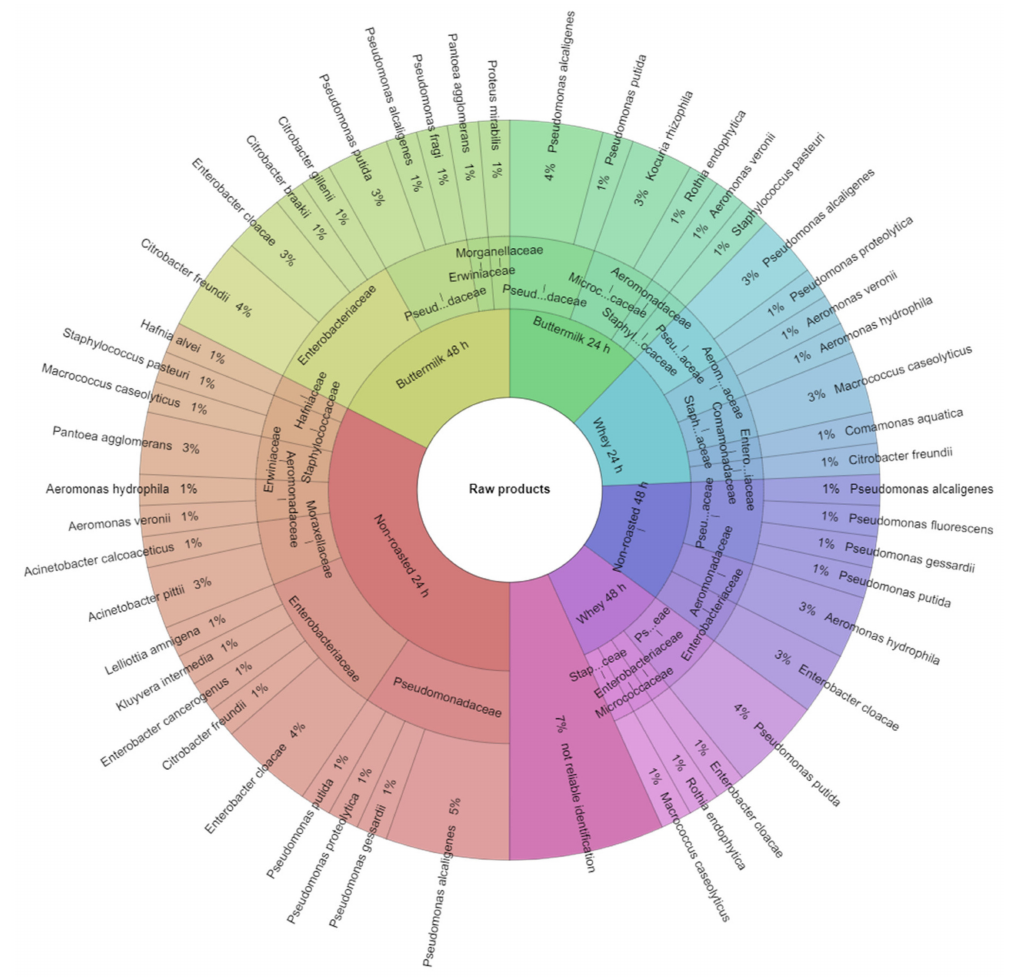
Figure 1. Identified species and family of bacteria in the raw